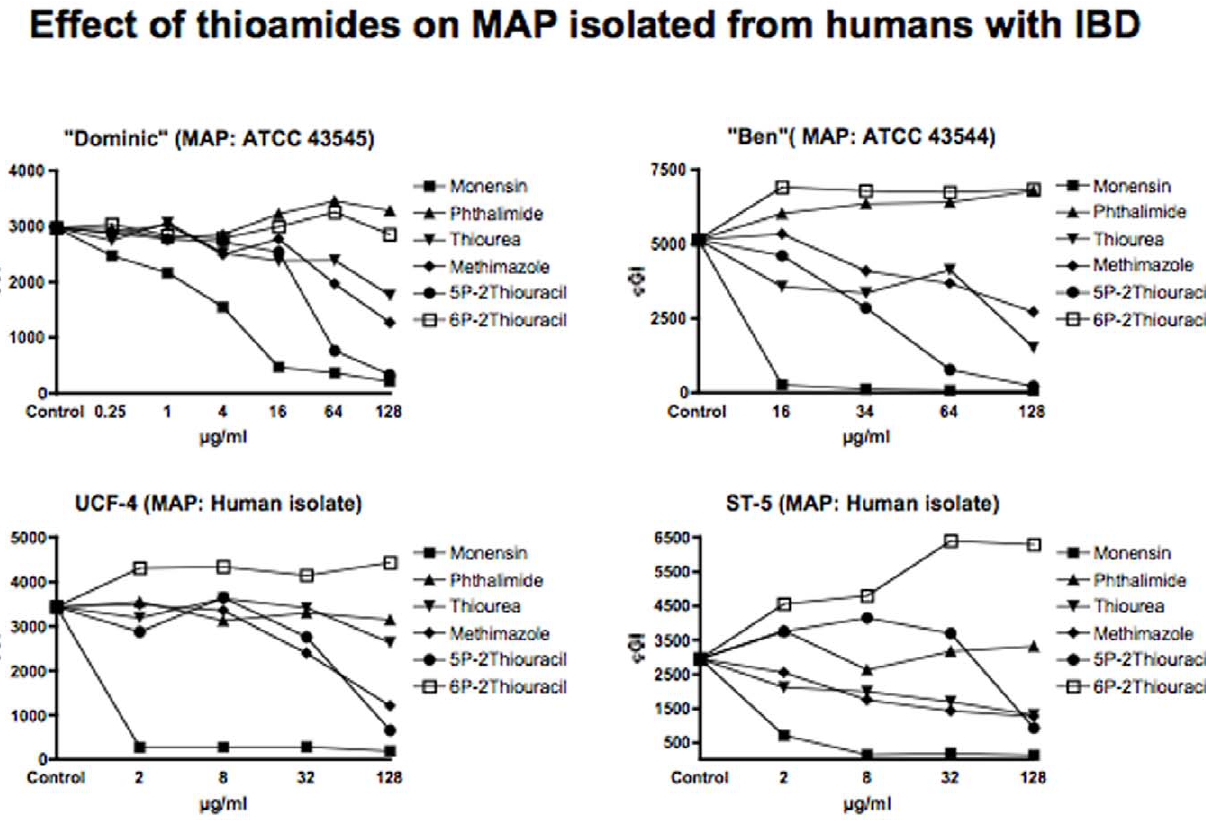
Figure 1. Shown are the cumulative Growth Indices (cGI) for the four MAP strains isolated from humans with Crohn disease. The positive control is Monensin, and the negative control is Phthalimide. Note that 5-PTU is consistently the most effective agent, and 6-PTU exhibits no inhibition. Methimazole is consistently more effective than Thiourea.